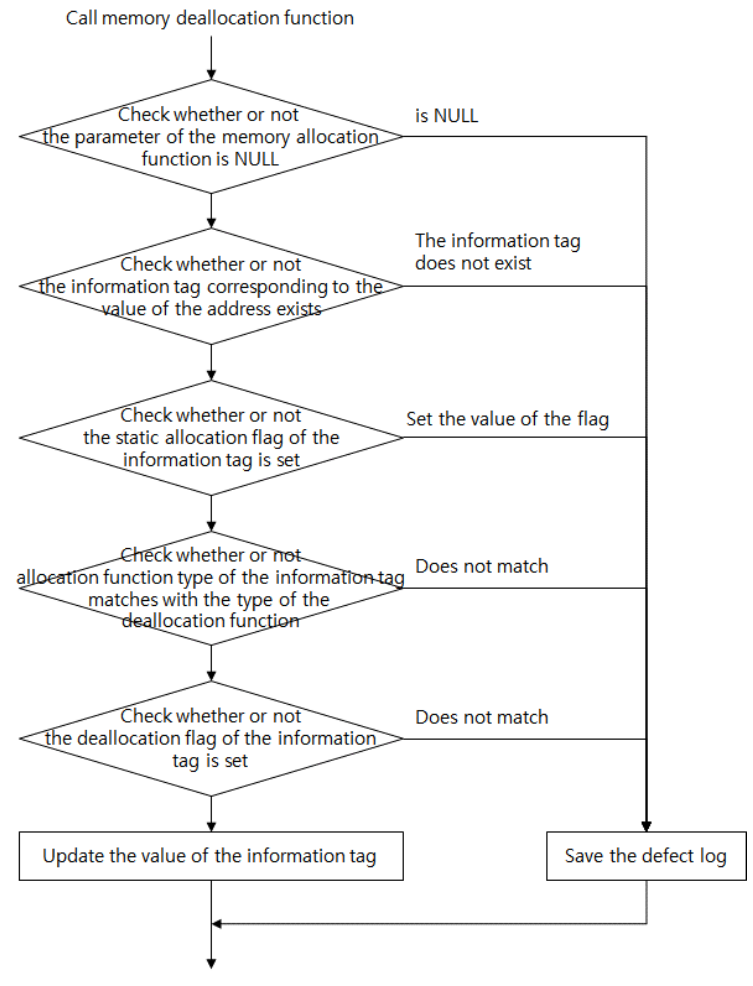
Figure 7. Real-time defect-detection: memory deallocation.